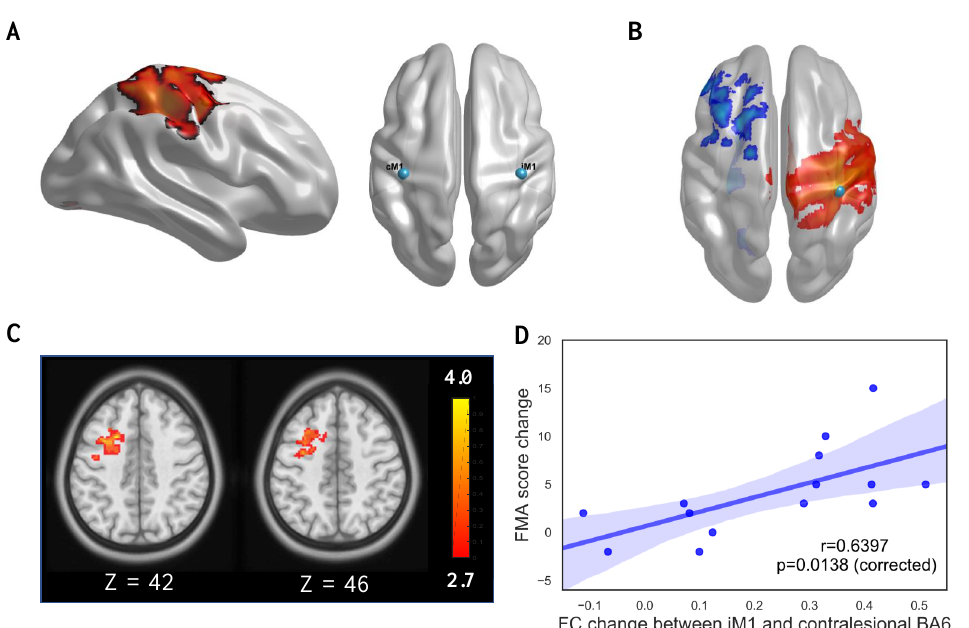
Figure 2. Seed selection and FC analysis result. ( A ) The color-coded area in the ipsilesional side of brain was significantly activated when subjects were doing the task according to task-based fMRI analysis. The right part demonstrated the locations of iM1 and cM1 seeds. The coordinate of iM1 and cM1 was at (38, − 22, 56) and ( − 38, − 22, 56), respectively, in Montreal Neurological Institute (MNI) space. ( B ) The color-coded area showed the FC map in the Pre session. ( C ) Functional connectivity between contralesional BA6 and iM1 seed was significantly changed. The color bar represents Z score. The white numbers aside the images represent the coordinate in MNI space. ( D ) Significant correlation was found between FMA score changes and functional connectivity